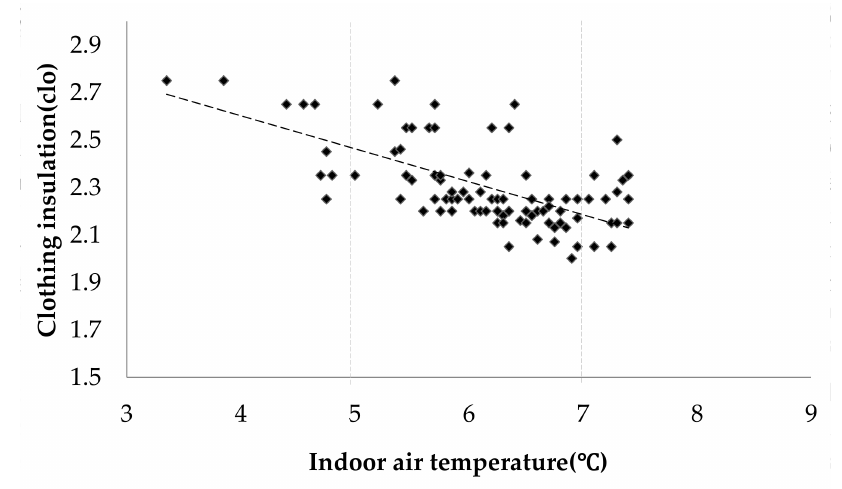
Figure 9. Adaptive behaviours in winter: ( a ) Dressing example in winter; ( b ) Small windows in stone houses; ( c ) Brazier; ( d ) Drinking milk or buttered tea.